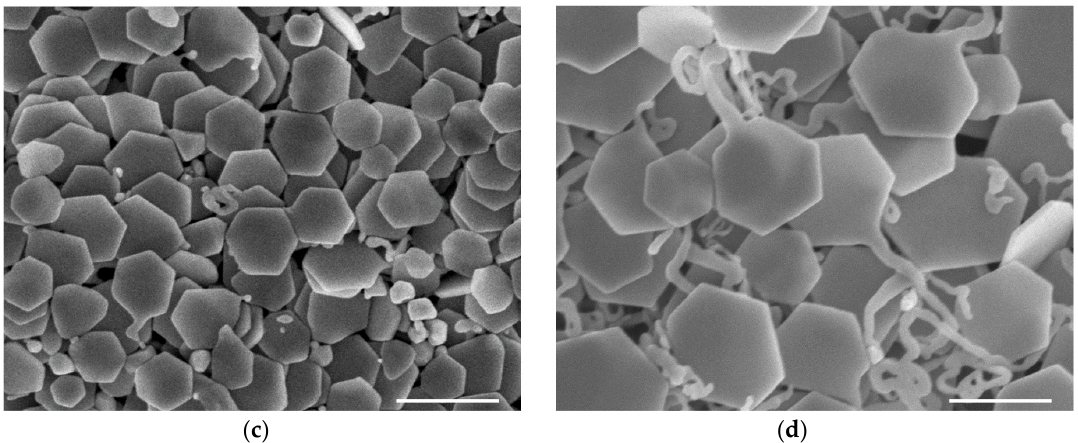
Figure 4. The SEM images about the results of using different amounts of SA in the synthesis of SNPs after 2 h: ( a ) blank experiment without SA; ( b ) 10, ( c ) 50, and ( d ) 100 μ L SA. The scale bar is 500 nm.